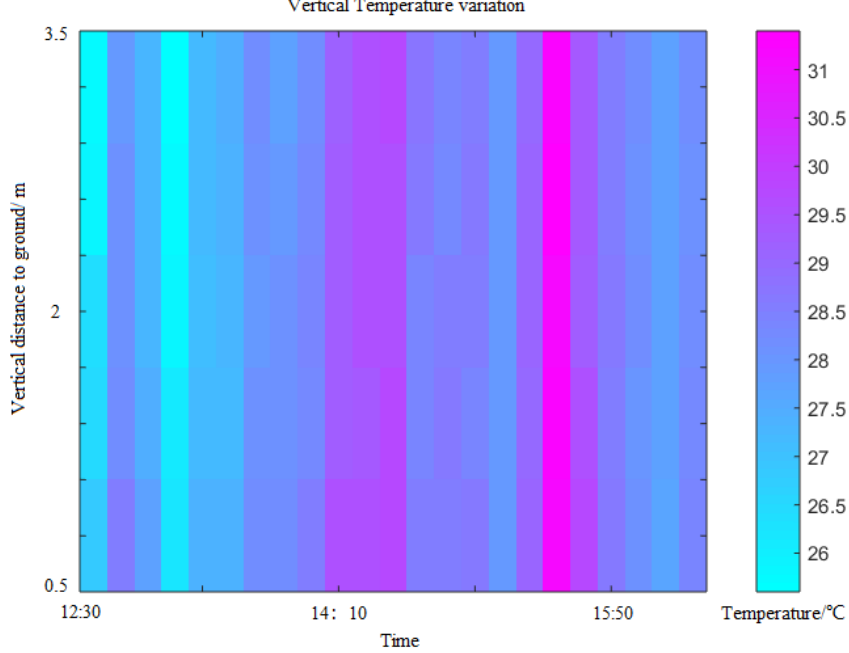
Figure 7. 0.5–3.5 m height vertical temperature distribution under the canopy.